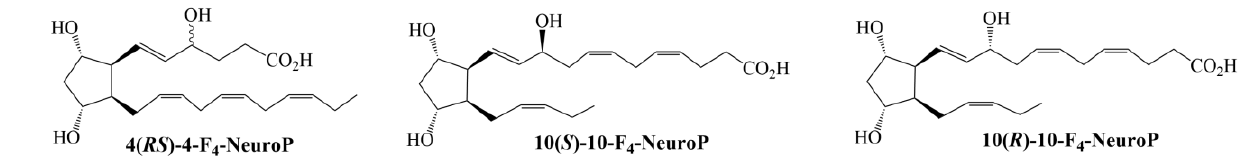
Figure 3. Representation of chemical structures of 4- and 10-F 4t -NeuroP isomers.